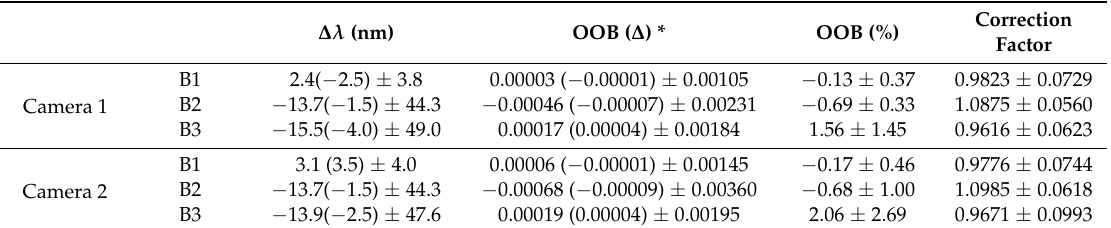
Table 3. CZI OOB and correction factor in the turbid waters. ∆ λ represents the shift of the effective central wavelength λ E relative to nominal one λ N .